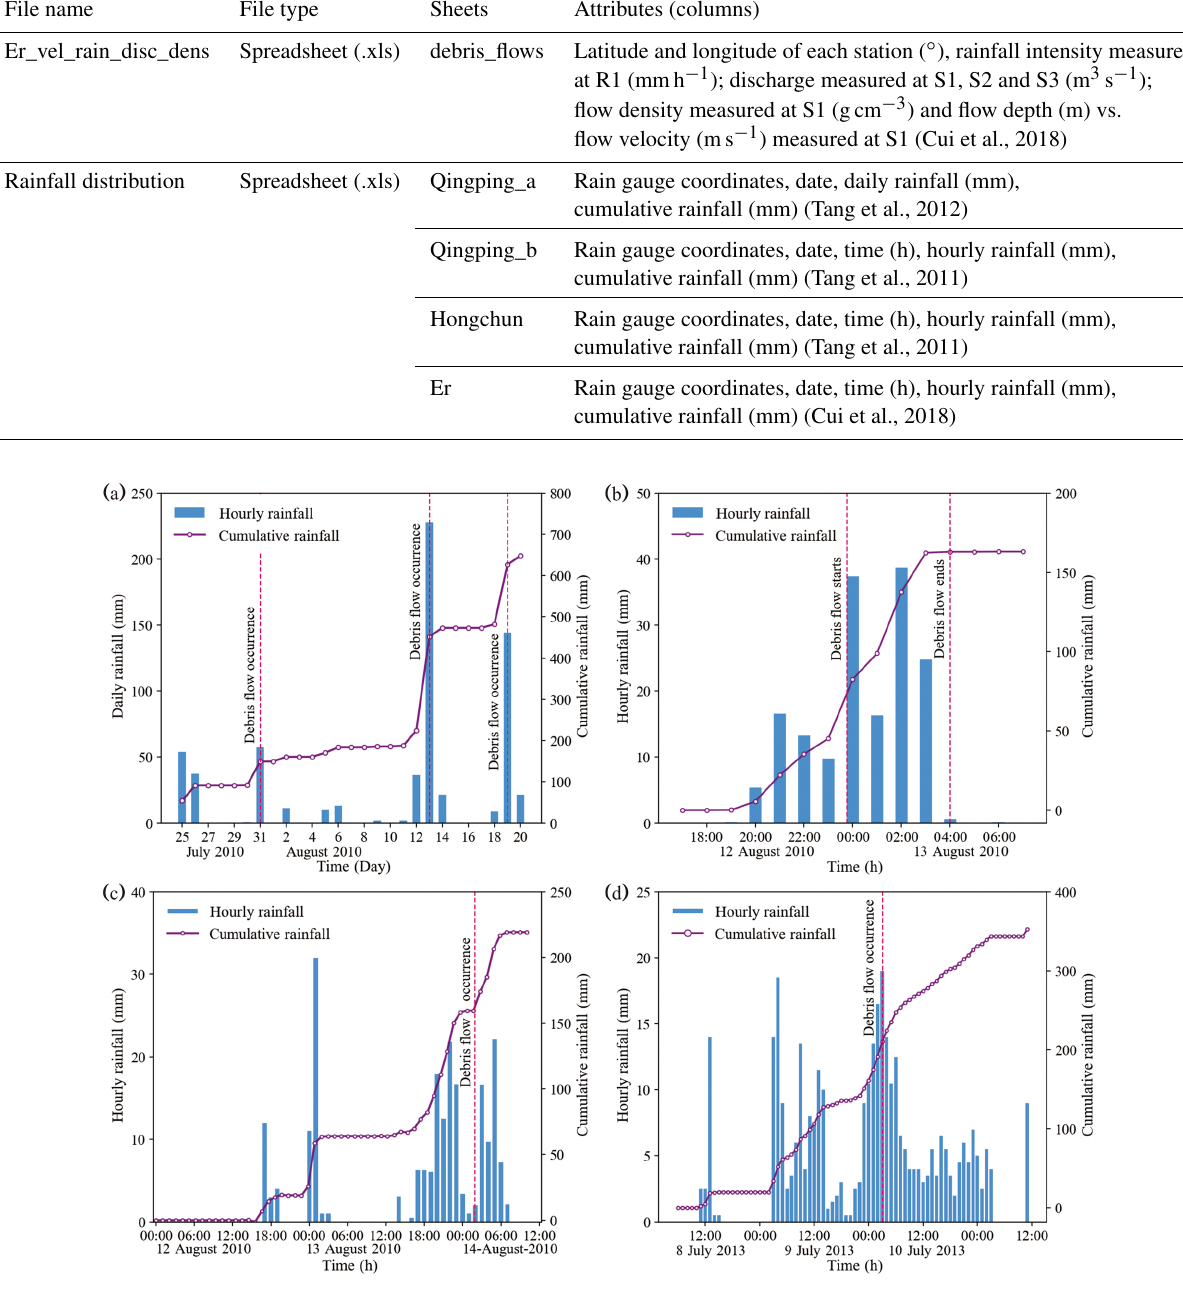
Figure 11. (a) Daily and accumulated precipitation in Qingping (Wenjia gully, CID M9, Mianzhu County; no. 4 in Fig. 1c) during a period affected by the three debris flow events. The DF_ID of these events are, chronologically, 272, 302 and 273. Rainfall data were recorded by a rain gauge located in Nanmu (CID M22, lat 104.154533, long 31.48832, Yu et al., 2010). (b) Detail of the second debris flow (DF_ID 302) that occurred between 12 and 13 August 2010 in Qingping: hourly and accumulated precipitations and event start and end are represented. (c) Hourly and accumulated precipitation in Hongchun (CID W25, Wenchuan County; no. 2 in Fig. 1c). A debris flow occurred on 14 August 2010 (DF_ID 53). Rainfall data were recorded by a rainfall gauge located in Yingxiu (lat 103.4826, long 31.06417). (d) Hourly and accumulated precipitation in Er (CID W7, Wenchuan County; no. 1 in Fig. 1c). A debris flow occurred on 10 July 2013 (DF_ID 164). Rainfall data were recorded by a rainfall gauge located in Er (lat 103.46088, long 31.11679; R1 in Fig. 13a; Cui et al.,